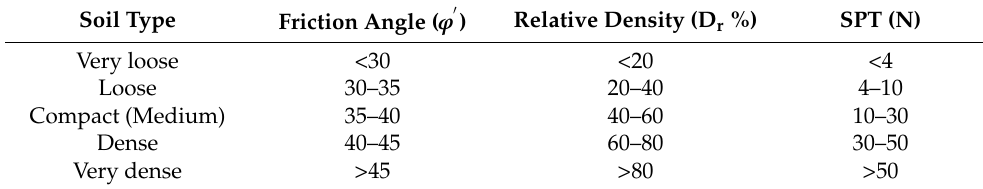
Table 2. Correlation between relative density, SPT N value, and the internal friction angle for different cohesionless soils [15–17,33].